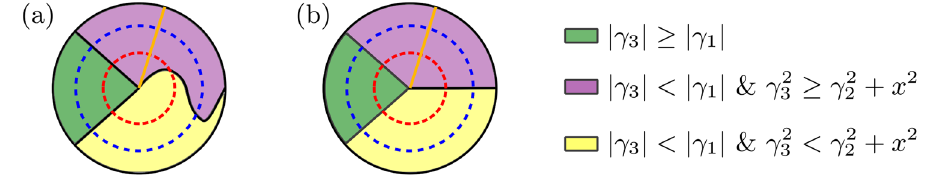
Figure 8. Visualization for possible trajectories of state dynamics (color online). The cases are divided between initial states satisfying ( a ) x ≠ 0 and ( b ) x = 0. The space of states is represented by a clock-face and split into three colored segments. The channel strength p corresponds to the rotation angle θ ( p ) of the orange hand of the clock. The red and blue dashed circles represent possible trajectories of Φ X ( ) pU and Φ X ( ) pL , respectively. As p increases, the clock hand rotates moving the evolved state along the dashed circle which corresponds to the noise location. The value of θ (0) is determined by the initial state and the behavior of θ ( p ) depends on the channel Φ and the initial p